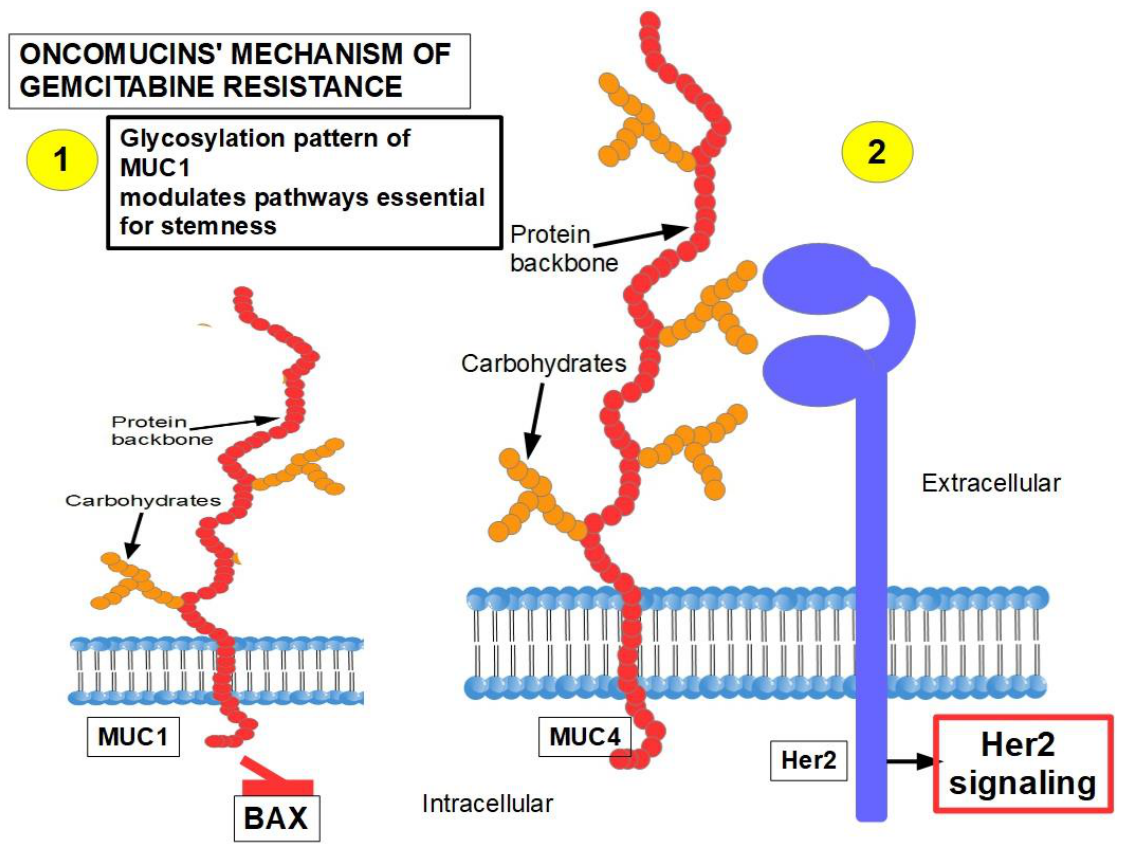
Figure 9. The two mechanisms involved in treatment resistance induced by oncomucins. This diagram is based on references [330 – 343].